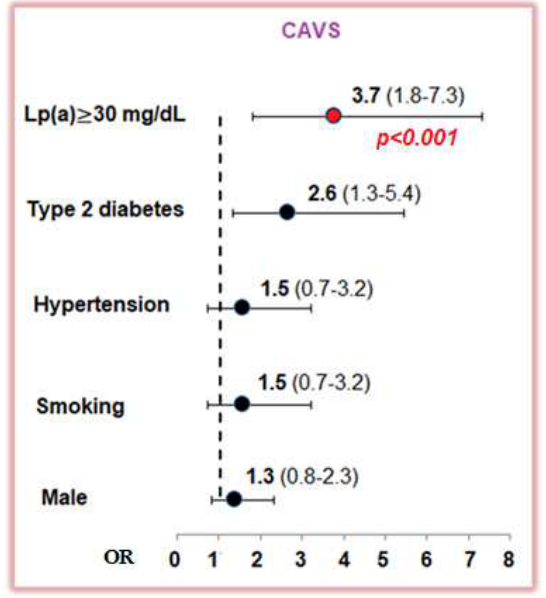
Figure 1. The odds ratio for calcific aortic valve stenosis according single-factor analysis for lipopro- tein(a) ≥ 30 mg/dl and classic risk factors. CAVS—calcific aortic valve stenosis; Lp(a)—lipopro-